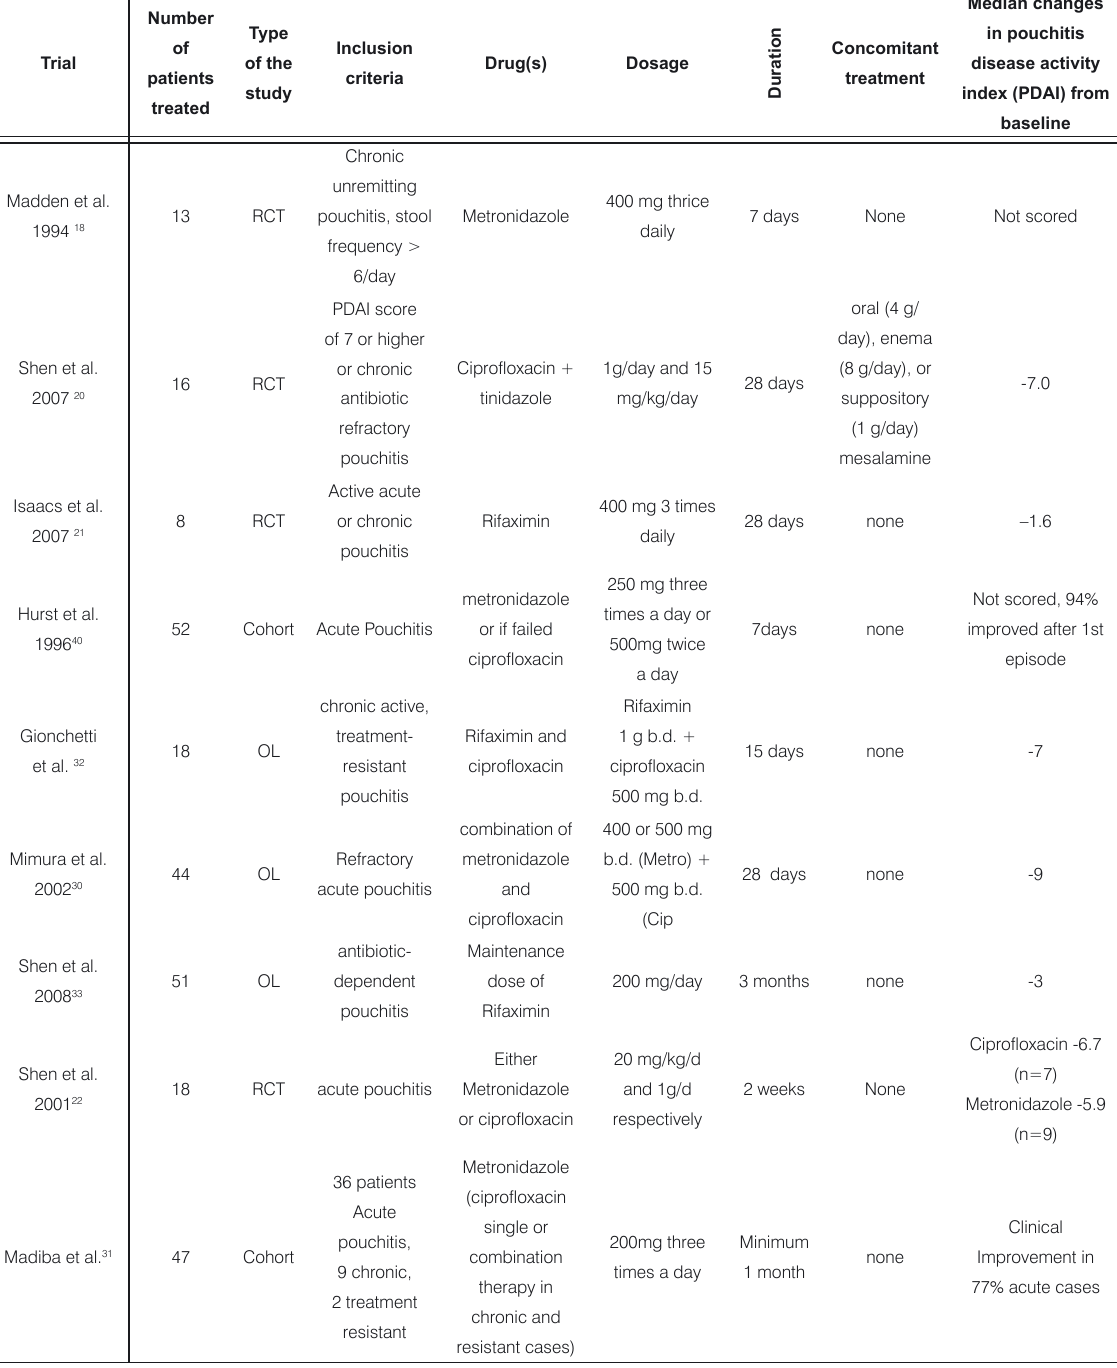
Table 1. Summery of clinical studies investigating the effect of antibiotics in treatment of